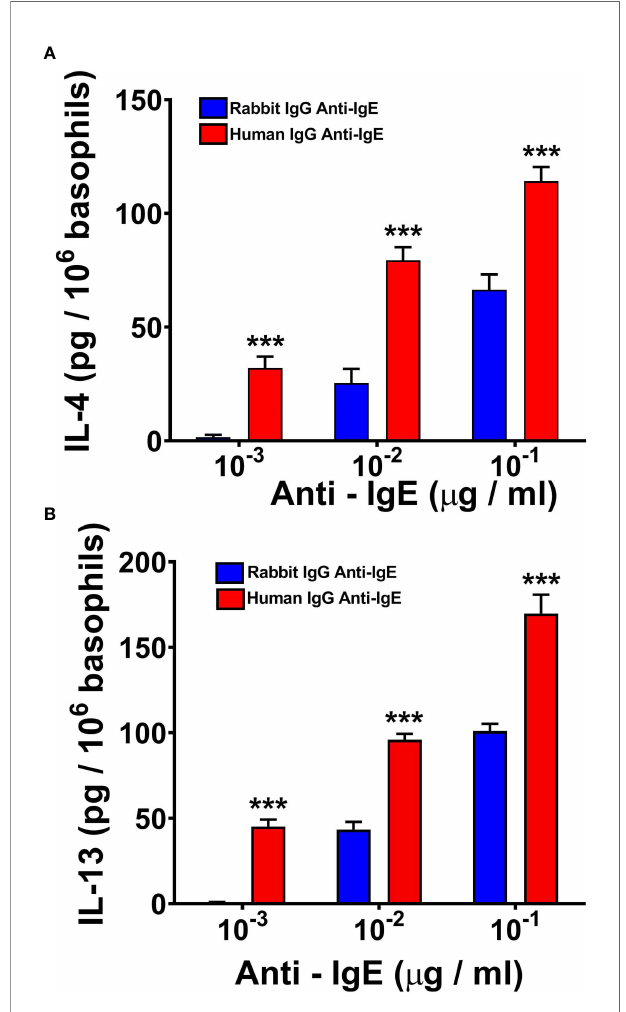
FIGURE 2 | Effects of increasing concentrations of human IgG anti-IgE (red bars) and rabbit IgG anti-IgE (blue bars) on IL-4 (A) and IL-13 (B) release from human basophils obtained from fi ve donors. Basophils were incubated with secretagogues for 4 hours (IL-4) or 18 hours (IL-13) at 37°C. Each bar represents the mean ± SEM in fi ve parallel experiments. Error bars are not shown when graphically too small. *** p < 0.001 when compared to the corresponding value obtained with rabbit IgG